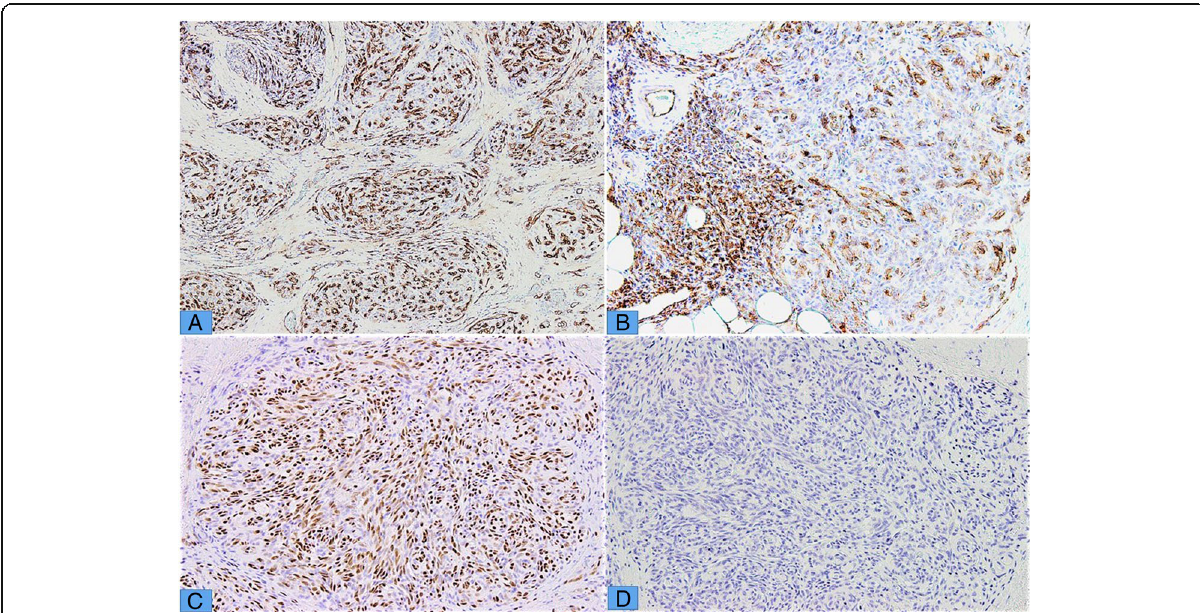
Fig. 3 a & b CD34 and CD31 highlighting endothelial cells. c Nuclear staining of ERG in endothelial cells d Negative staining of